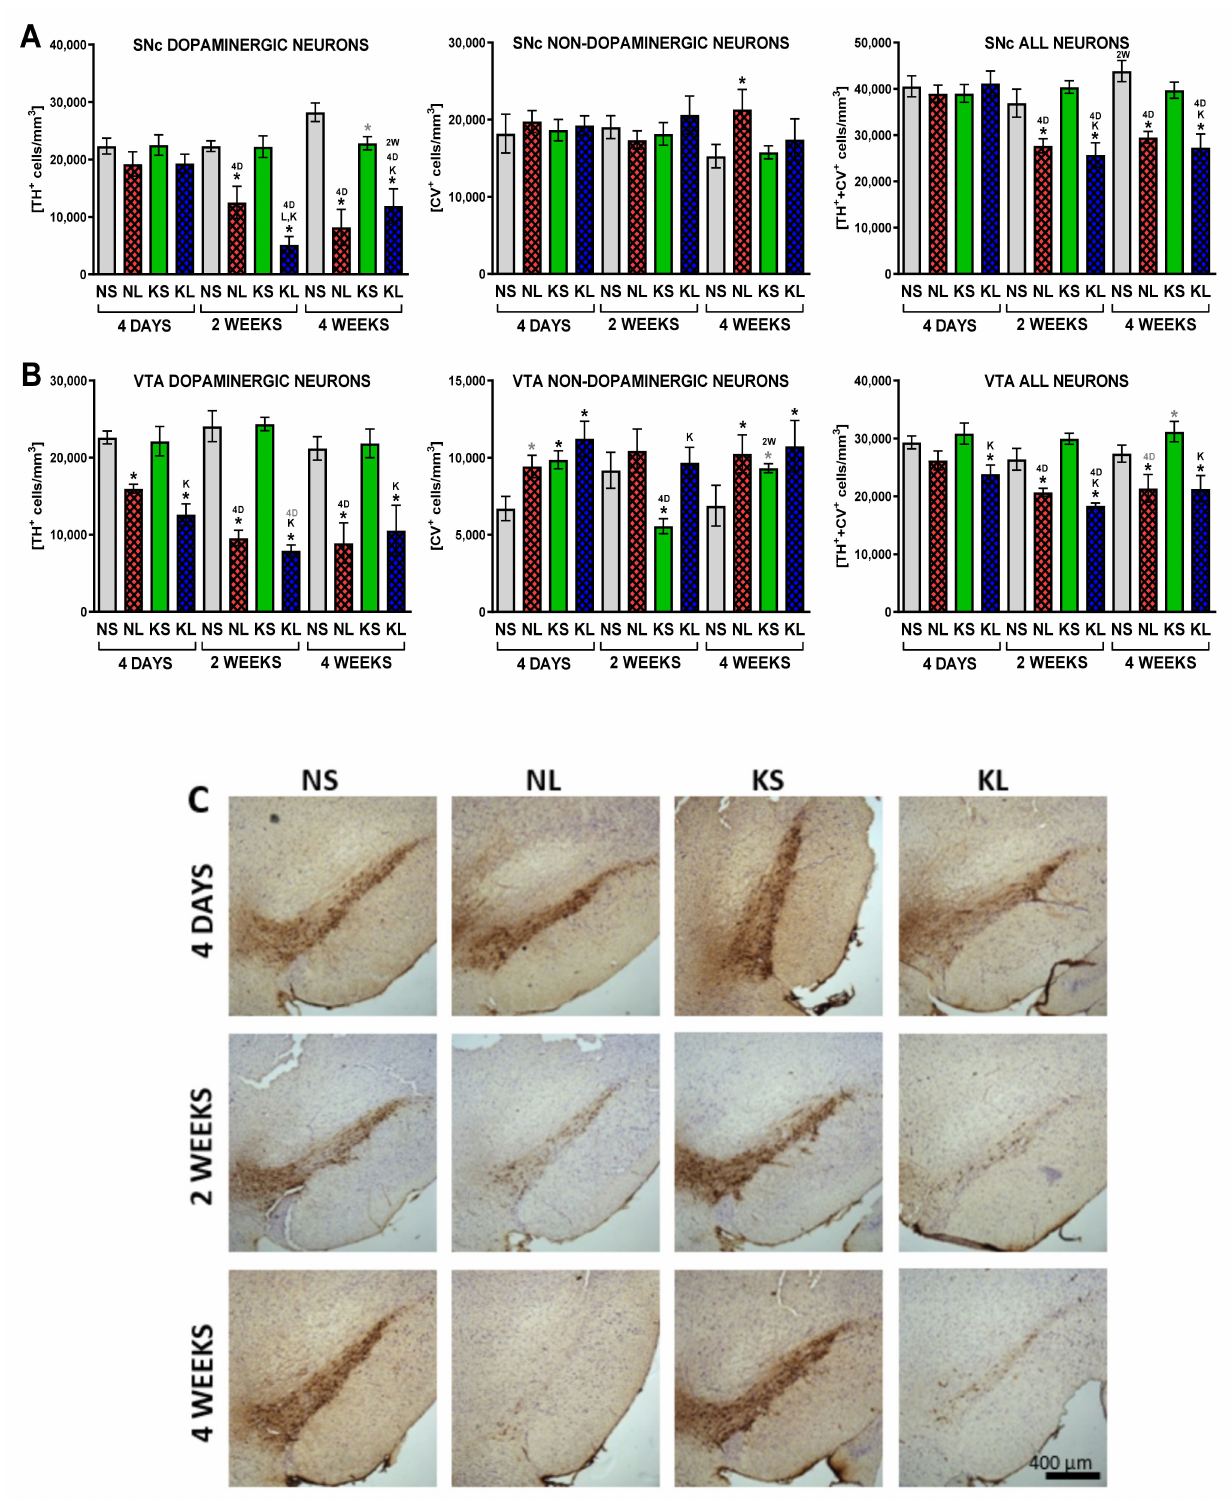
Figure 5. Stereological counting of dopaminergic and non-dopaminergic neuron density in the SN ( A ) and VTA ( B ) with representative photographs ( C ) stained for TH and cresyl violet. Data are presented as mean ± SEM. Analysis was performed at time-points 4 days, 2 weeks, and 4 weeks after brain surgery. Animals were kept on ketogenic diet for 3 weeks in advance. p value ≤ 0.05 was set as significance threshold and marked as * vs. normal diet + sham (NS group), L vs. normal diet + 6-OHDA lesion (NL group), K vs. ketogenic diet + sham (KS group), KL stands for ketogenic diet + 6-OHDA lesion group, 2W vs. 2 week time-point, 4D vs. 4 day time-point. Statistical trends 0.05 < p ≤ 0.1 were marked in grey symbols. Statistics: 3 way ANOVA with LSD post hoc test. Number of animals was 4–7 per